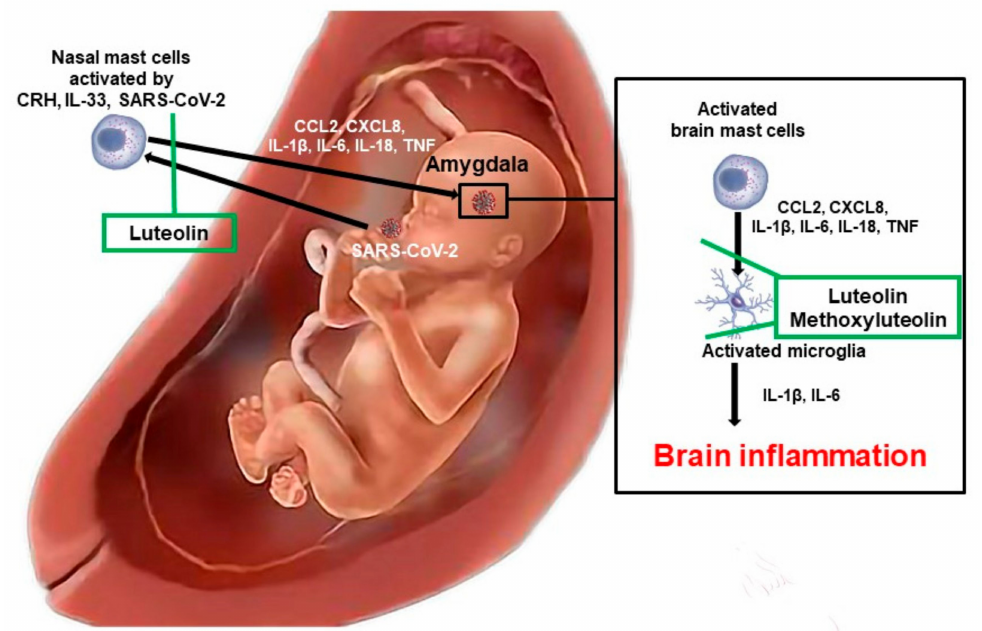
Figure 1. Diagrammatic representation of how SARS-CoV-2 could stimulate fetal mast cells and result in inflammation of the brain. SARS-CoV-2 could stimulate fetal or neonatal mast cells especially in the nose and enter the brain via the olfactory nerve tract, reaching the amygdala. There, it could further activate mast cells and microglia to release pro-inflammatory mediators, thus contributing to brain inflammation and ASD. Luteolin could block these